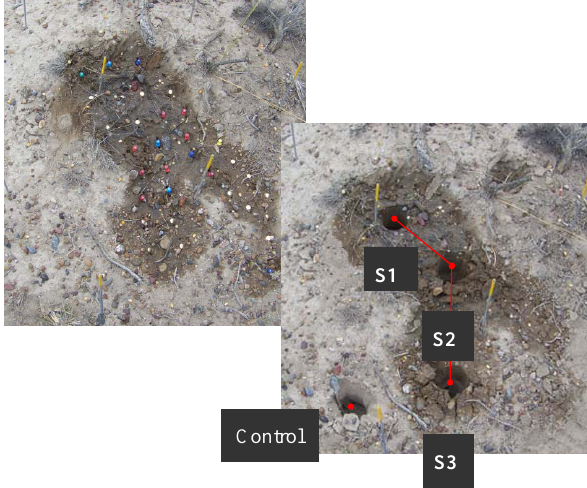
Fig. 1. Left panel: overhead view of a field plot in this study at the end of the water inflow period with TDR probe position marks and spikes with control marks used in the CRS-GSM procedure. Right panel: soil cores along the main axis of the overland flow area are already extracted. Flow occurred in the direction S1 to S3.